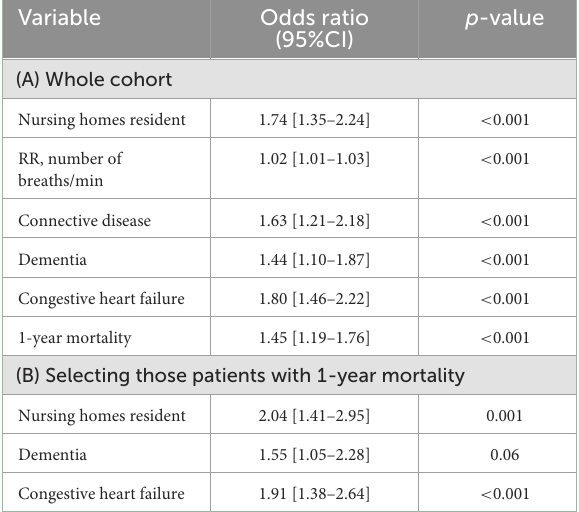
TABLE 4 Multivariate logistic regression for patients with COVID-19 vs. patients without COVID-19. Variable Odds ratio